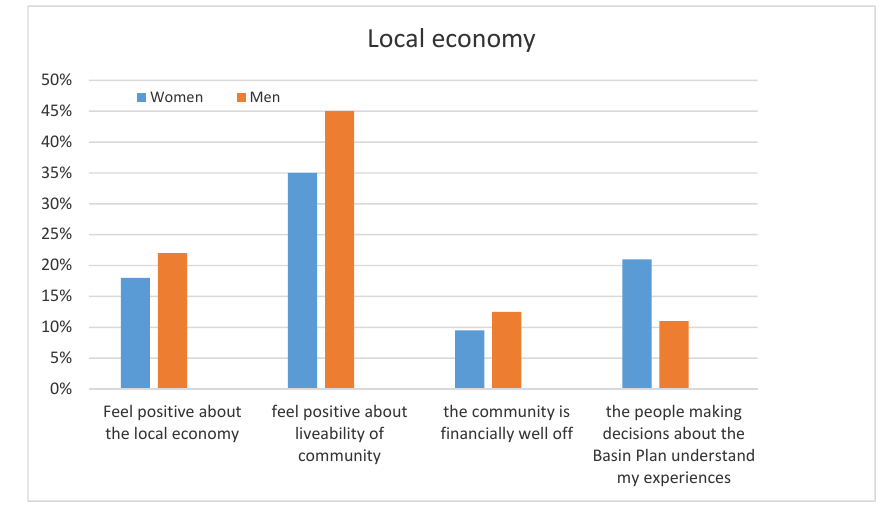
Figure 2. Views on the local economy.